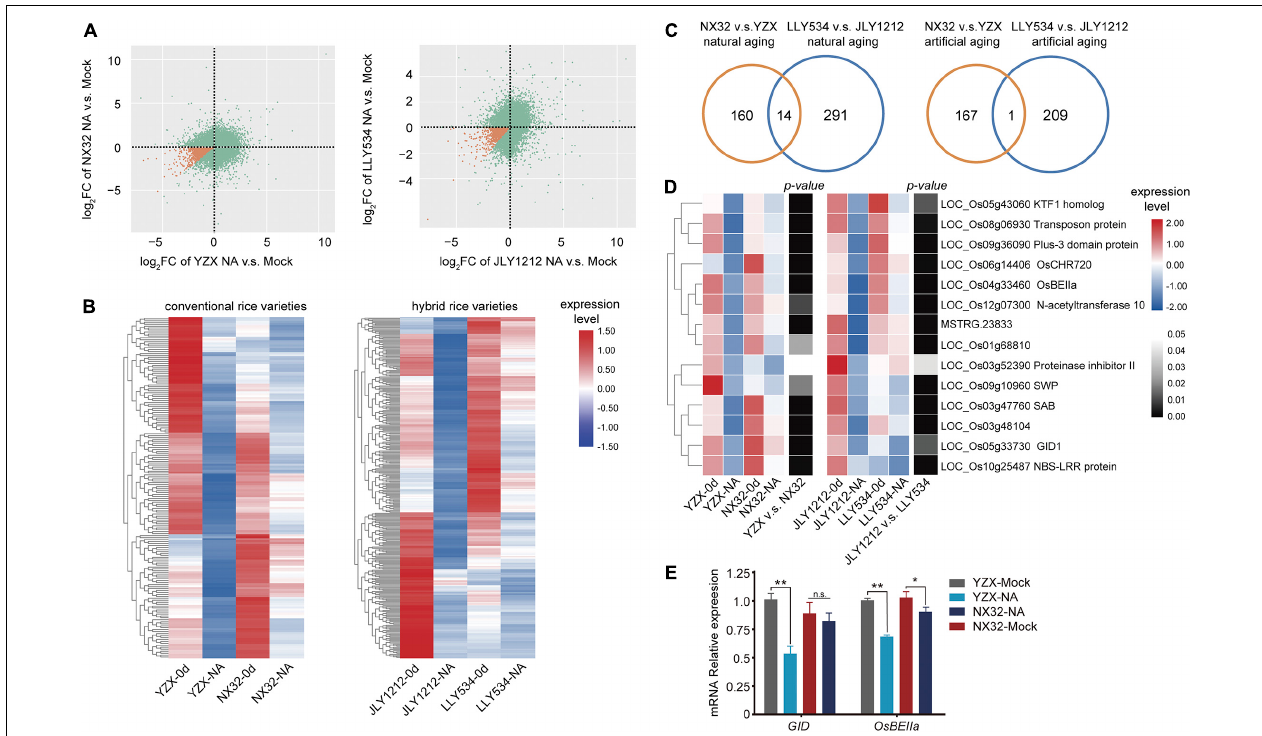
FIGURE 6 | Heatmap analysis of long-lived mRNAs in HL and LL varieties. (A) Figure showing the log 2 FC in NX32, YZX, LLY534, and JLY1212 when comparing natural aging with mock treatment ( p < 0.05). The orange dots represent the specific long-lived mRNA. NA represent natural aging. (B) Heatmap of specific long-lived mRNAs that degrade significantly slower in HL varieties NX32 and LLY534 than in LL varieties YZX and JLY1212 when comparing naturing aging with mock treatment ( p < 0.05). (C) Venn diagram depicting the overlap of specific long-lived mRNAs that degrade significantly slower in HL varieties than in LL varieties ( p < 0.05) between NX32 vs. YZX and LLY534 vs. JLY1212 under natural and artificial aging conditions. (D) Heatmap of overlapping specific long-lived mRNAs that degrade significantly slower in HL varieties than in LL varieties ( p < 0.05) between conventional rice varieties (NX32 and YZX) and hybrid rice varieties (LLY534 and JLY1212) under natural aging conditions. NA represents natural aging. Black–white represents the p -value of the changes during the aging between HL and LL. (E) qRT-PCR analysis of GID1 and OsBEIIa expression in NX32 and YZX with or without natural aging. OsACTIN was used as the internal control. The data are presented as the mean ± SD ( n = 3) (n.s., not significant; * P < 0.05, ** P < 0.01, one-way ANOVA with Tukey’s